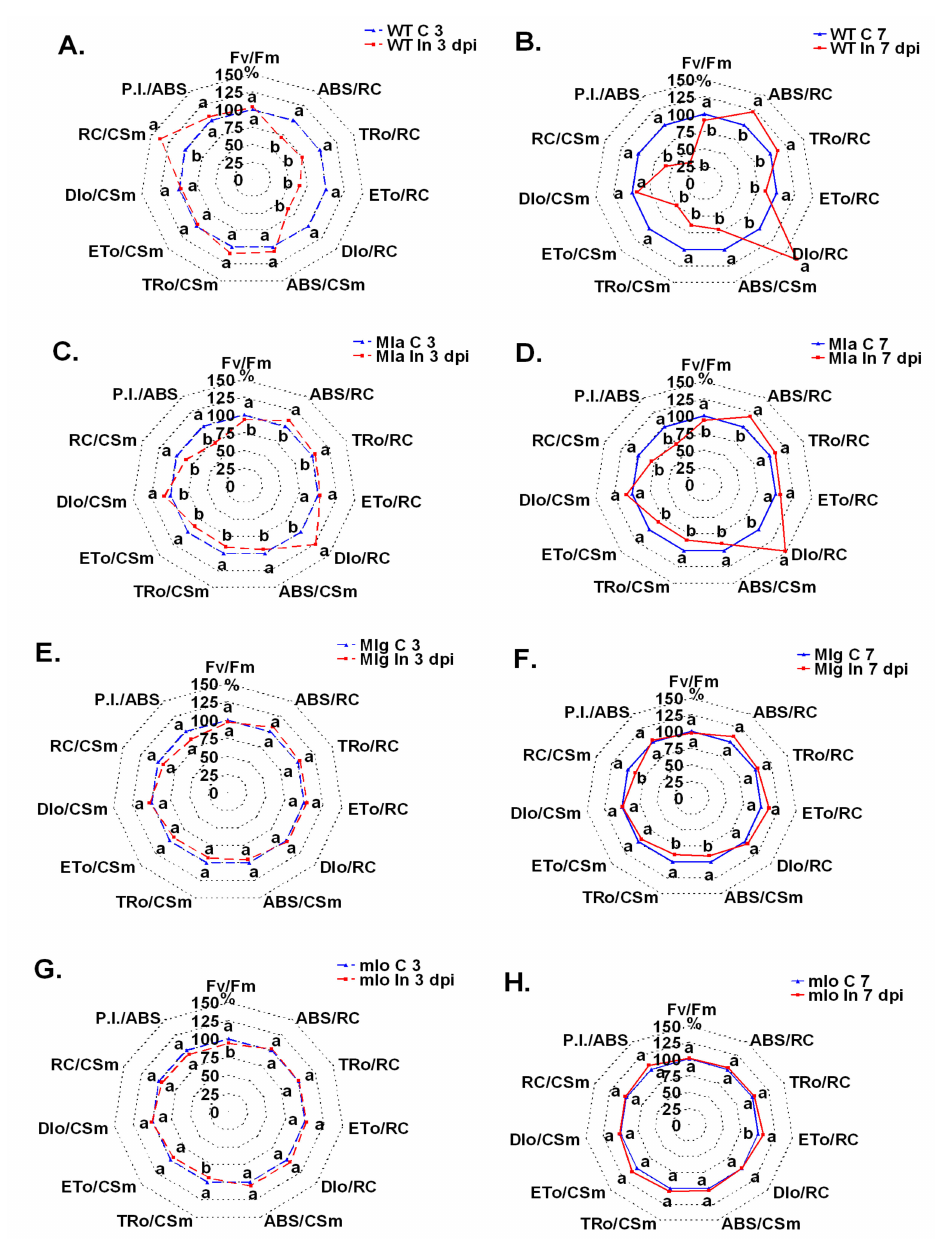
Figure 4. Photosystem II e ffi ciency in powdery mildew-inoculated near-isogenic barley leaves at 3 and 7 days post-inoculation (dpi) as compared to respective healthy control leaves (C 3 or C 7). Changes of 11 photosythetic parameters are presented in spider graphs as percentages of non-inoculated controls (100 %). Panels: ( A ), wild type Ingrid inoculated at 3 dpi vs. control; ( B ), wild type Ingrid inoculated at 7 dpi vs. control; ( C ), Mla inoculated at 3 dpi vs. control; ( D ), Mla inoculated at 7 dpi vs. control; ( E ), Mlg inoculated at 3 dpi vs. control; ( F ), Mlg inoculated at 7 dpi vs. control; ( G ), mlo inoculated at 3 dpi vs. control; ( H ), mlo inoculated at 7 dpi vs. control. Abbreviations: C, control; In, inoculated; WT, wild type Ingrid. Source data are available in Table S1. Values marked with the same letters are not di ff erent according to Duncan’s test ( p ≤ 0.05), n =